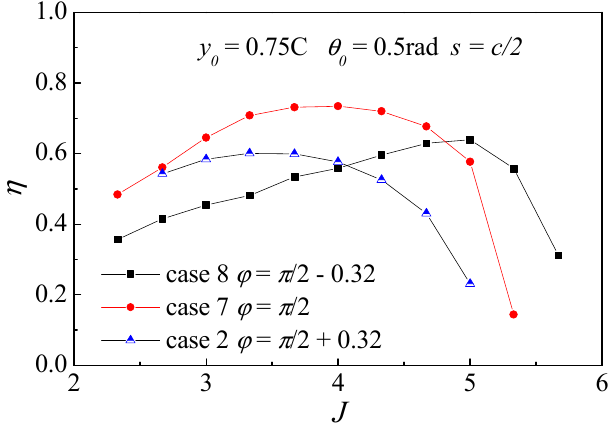
Figure 18. Propulsive efficiency comparison of the Case 3, Case 5 and Case 6.